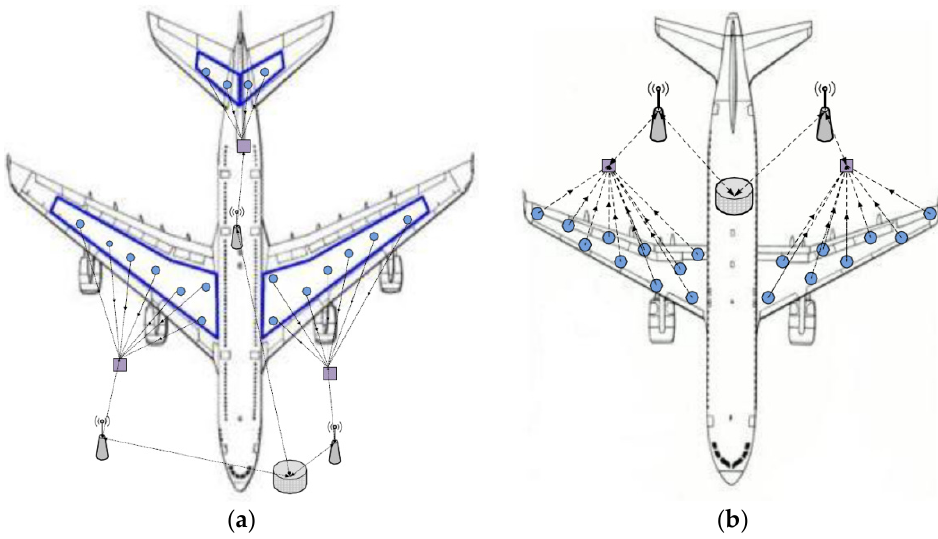
Figure 12. WSN installed in ( a ) fuel tanks and ( b ) wings [175].